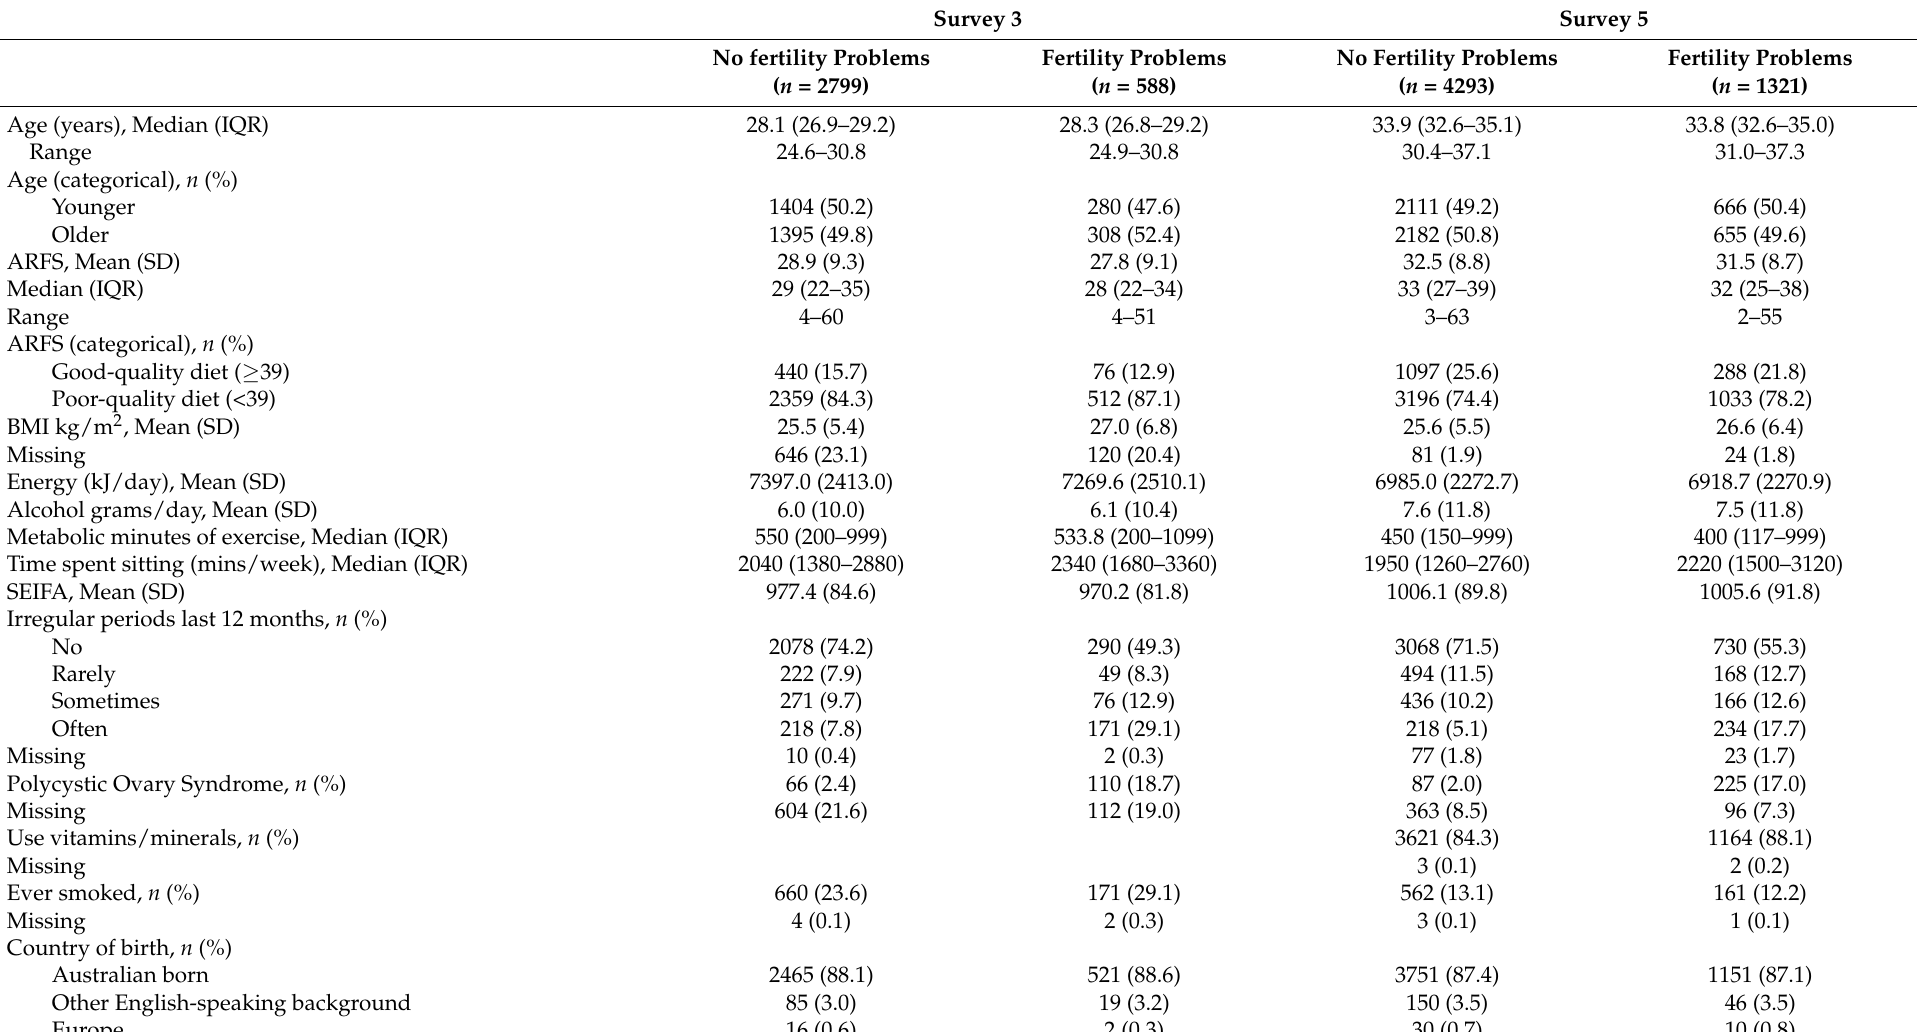
Table 1. Descriptive characteristics of the study population by infertility status in Surveys 3 and